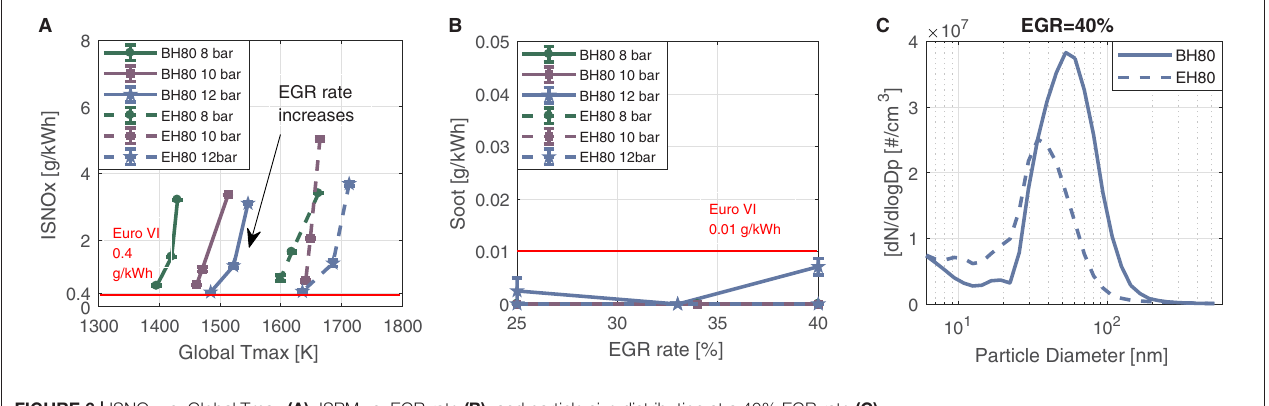
FIGURE 6 | ISNO x vs. Global Tmax (A) , ISPM vs. EGR rate (B) , and particle size distribution at a 40% EGR rate (C)